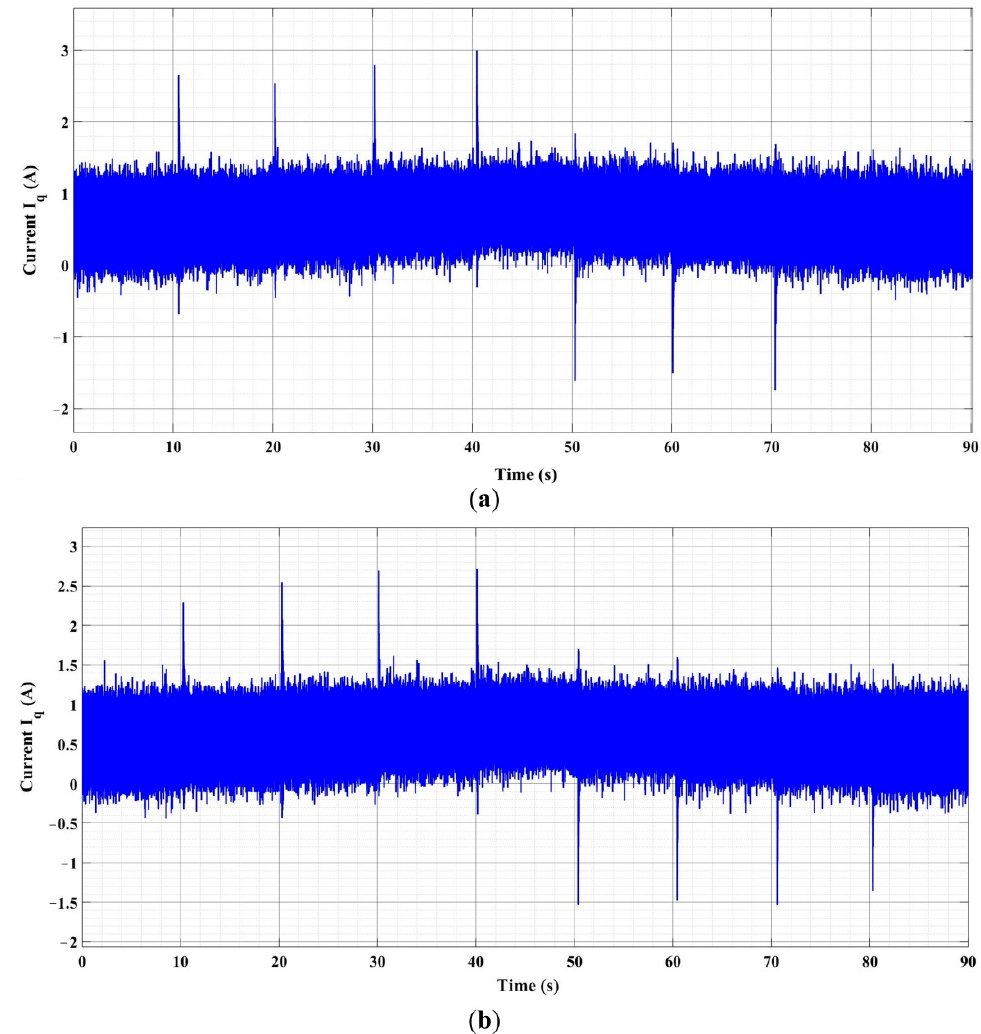
Figure 45. Comparative real-time evolution of the i q currents: ( a ) with PI-PSO controller; ( b ) with backstepping controller.